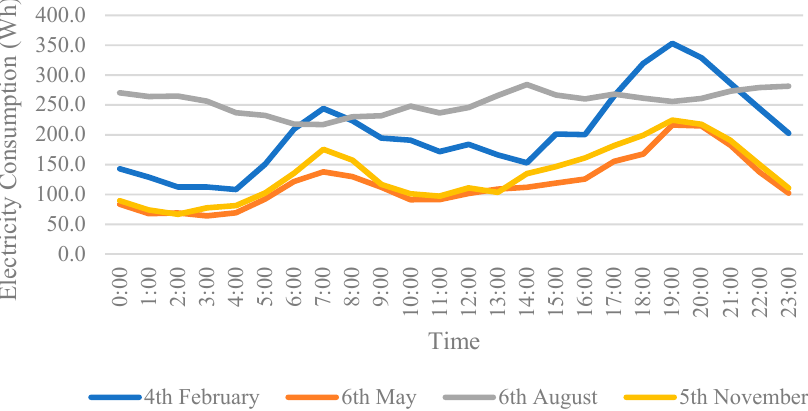
Figure 3. Comparison of the hourly average electricity consumption profiles for a low-consumption household during the four seasons.